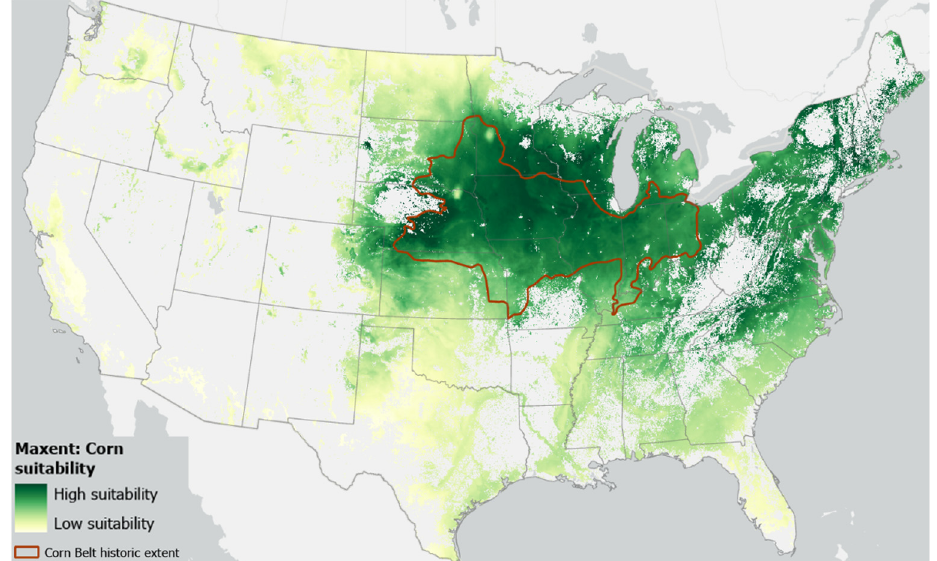
Figure 1. Corn suitability in the contiguous United States as modeled. Darker green areas represent greatest predicted corn suitability. Red outline represents the extent of the historic U.S. Corn Belt [55].